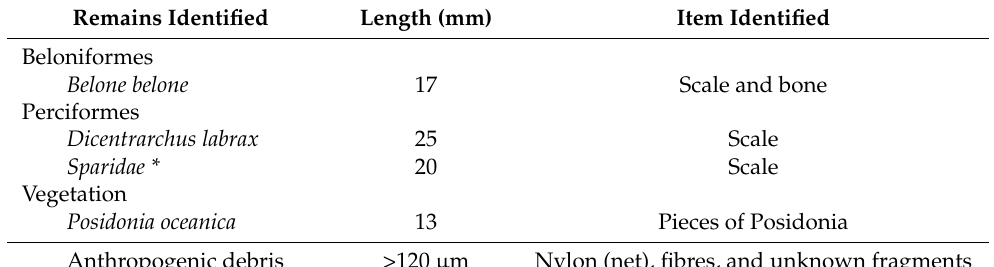
Table 1. Prey identified and anthropogenic debris incidence in monk seal scat recovered in Albania. Remains Identified Length (mm) Item Identified Beloniformes Belone belone 17 Scale and bone Perciformes Dicentrarchus labrax 25 Scale Sparidae * 20 Scale Vegetation Posidonia oceanica 13 Pieces of Posidonia Anthropogenic debris >120 µ m Nylon (net), fibres, and unknown